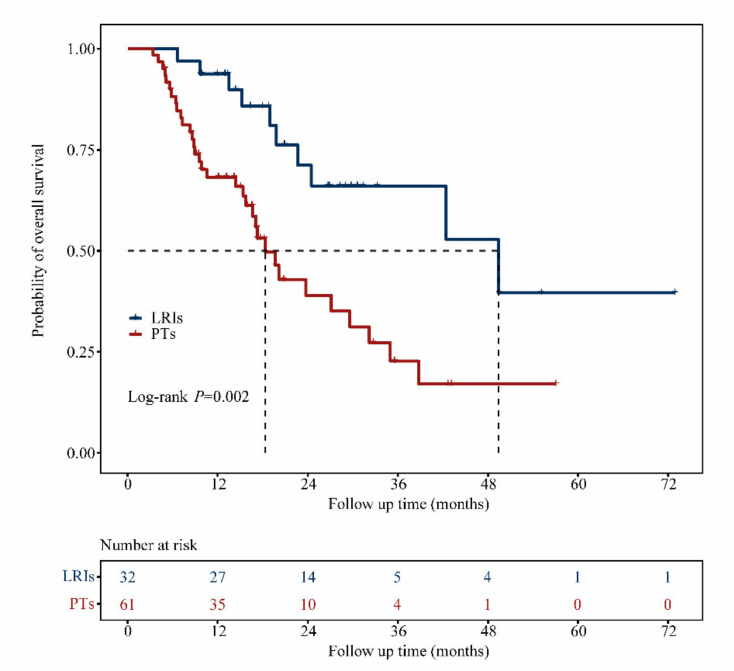
Figure 3. Kaplan–Meier analysis of OS in mCRC patients with the BRAF V600E muta- tion who received different treatments. Abbreviations: LRIs, locoregional interventions; PTs, palliative